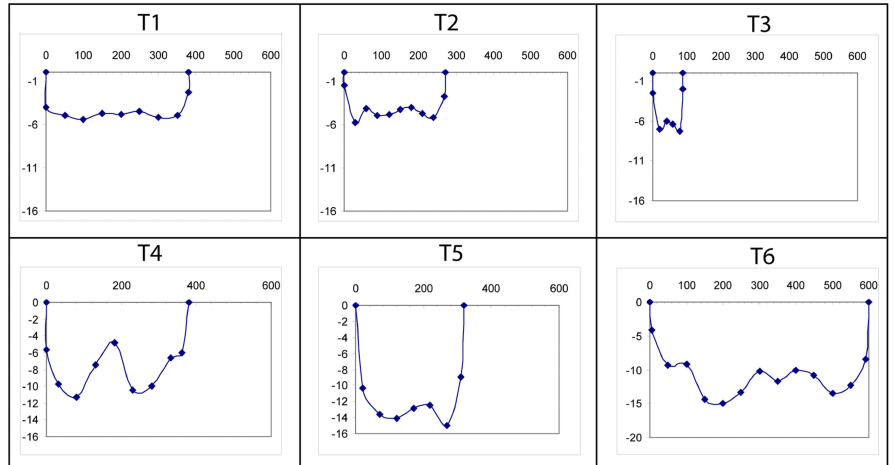
Figure 6. Bathymetric profiles obtained at 6 di ff erent sections in the bifurcation and in the confluence of the Casiquiare Channel. T1: Orinoco upstream of bifurcation; T2: Orinoco downstream of bifurcation; T3: Casiquiare at inlet; T4: Guainia River before confluence; T5: Casiquiare at outlet; T6: Negro River at San Carlos. Depths and widths are given in meters. See Figure 3 for location of cross sections collected in the 2000